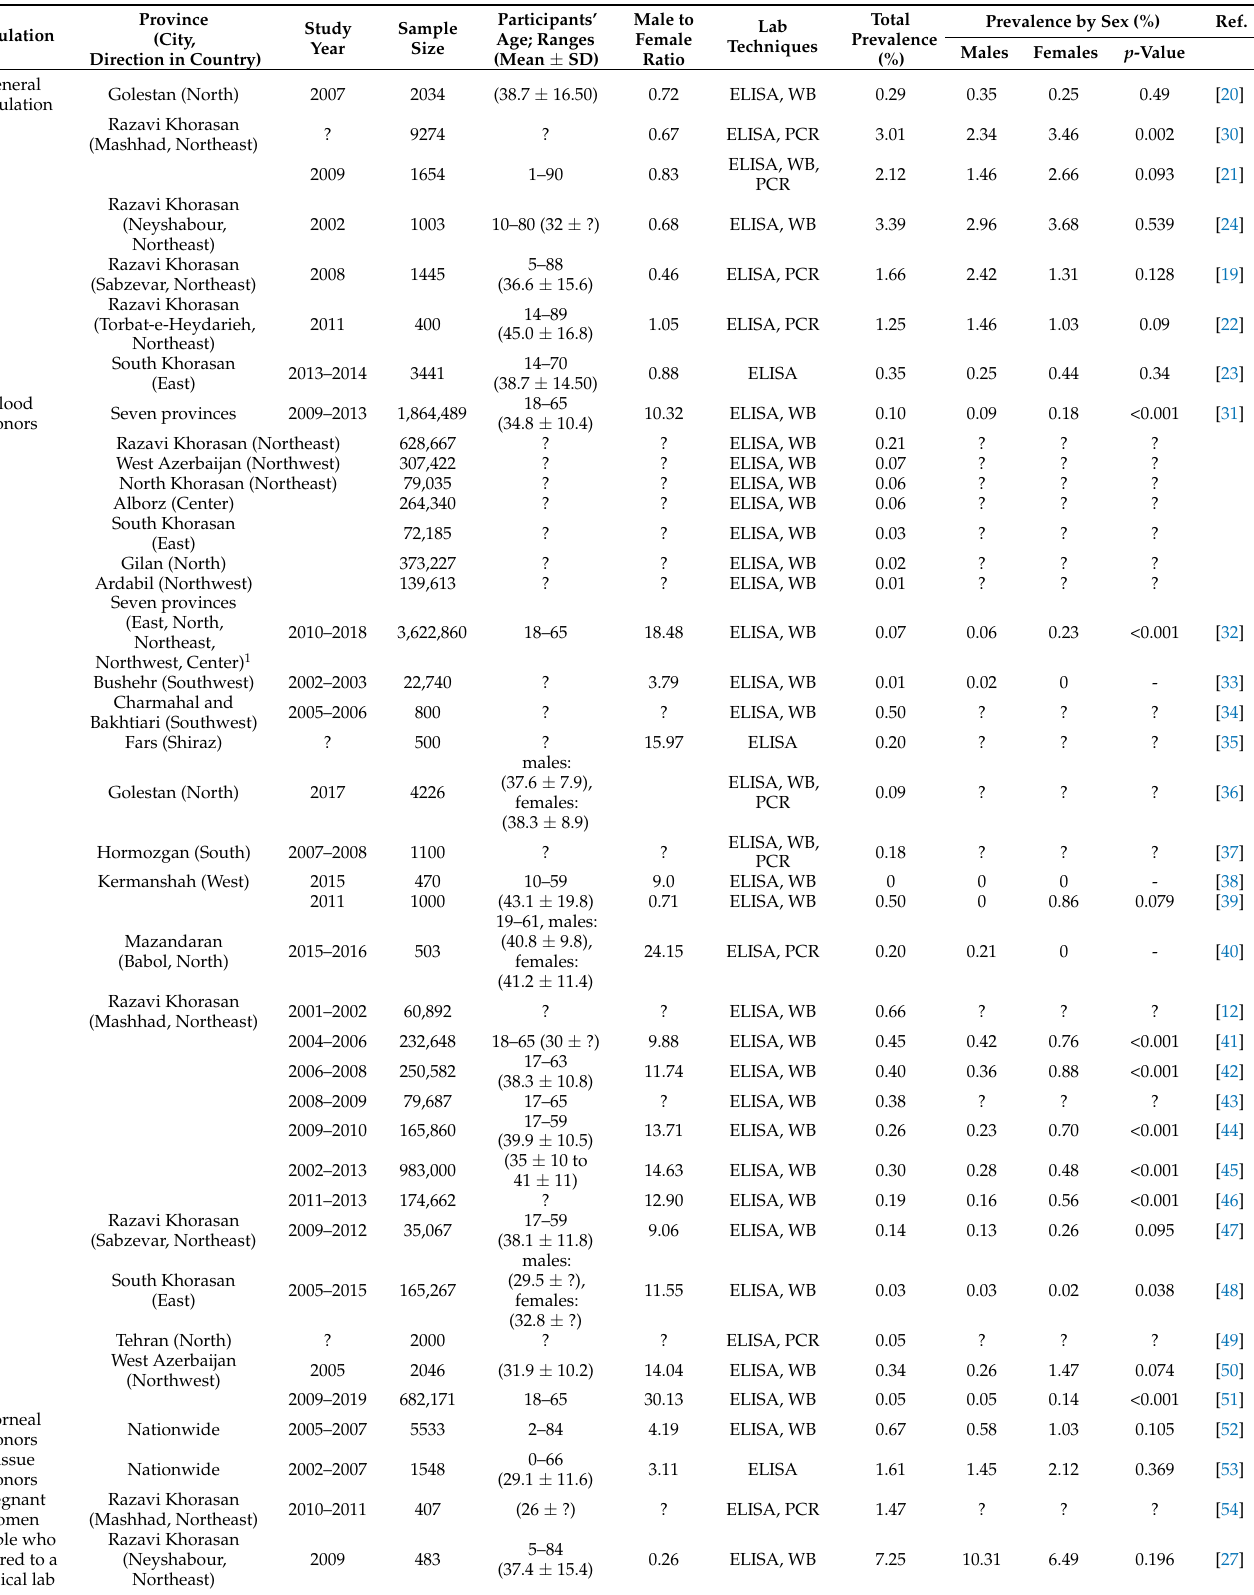
Table 1. Prevalence of HTLV-1 infection among low-risk population of Iran;